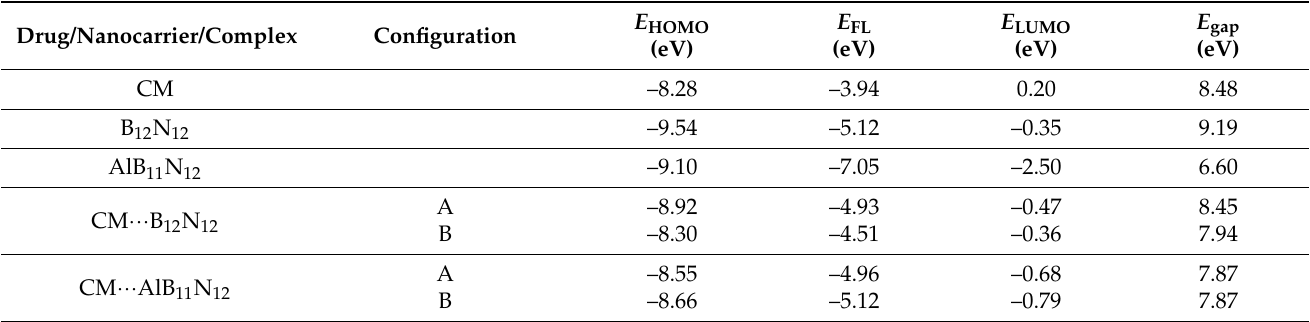
Table 3. The highest occupied molecular orbital ( E HOMO ), Fermi level ( E FL ), and the lowest unoc- cupied molecular orbital ( E LUMO ), as well as the energy gap ( E gap ) of optimized CM, B 12 N 12 , and AlB 11 N 12 before and after adsorption process. All values are given in